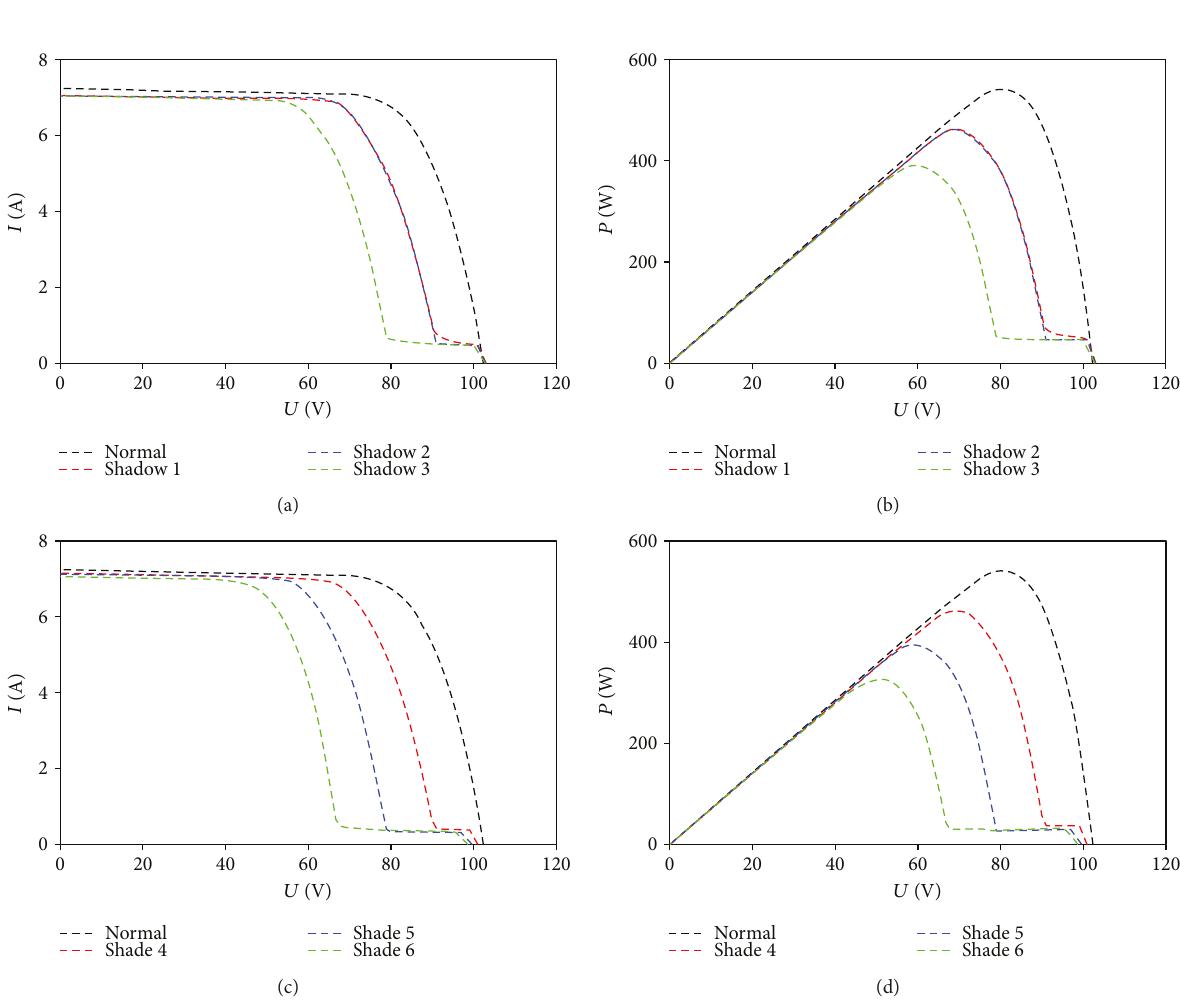
Figure 12: Results for the shadowing experiment. The curves are coincide with the simulation